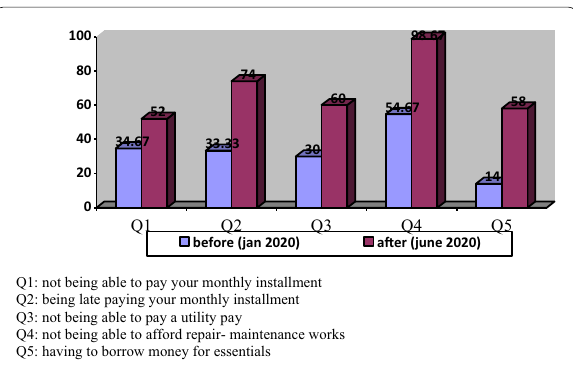
Fig. 6 Percentages of households who have experienced economic